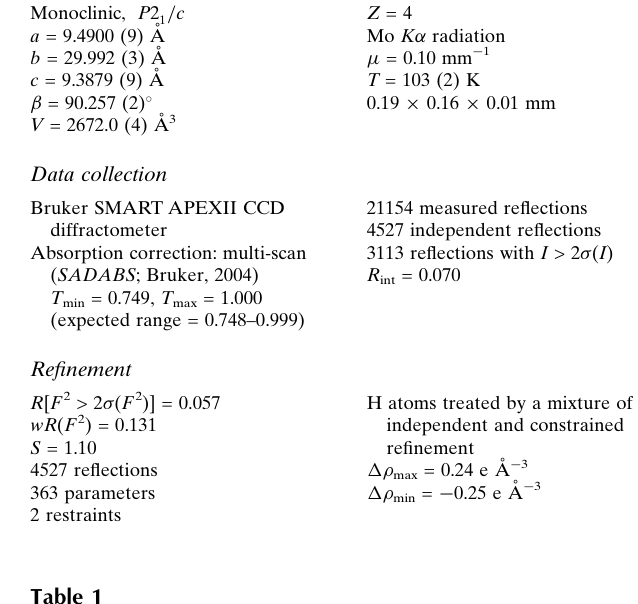
Hydrogen-bond geometry (A˚ , (cid:2)